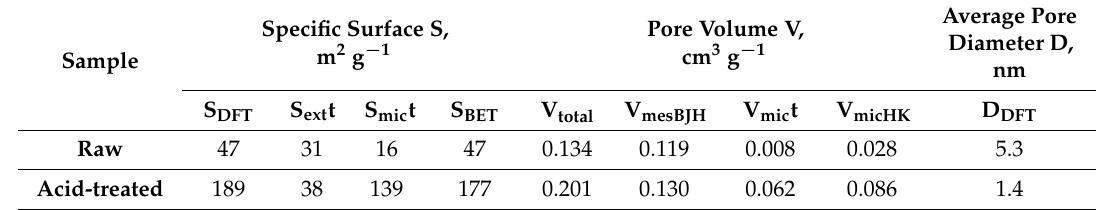
Table 2. The porous structure parameters of saponite samples.